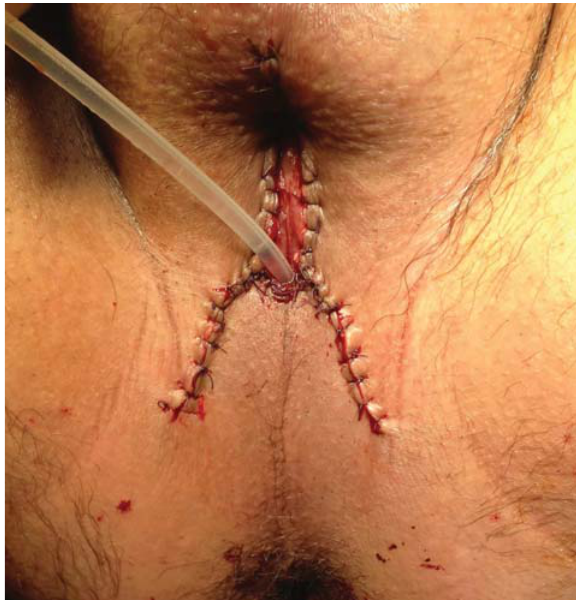
Figure 2 - Post-surgical